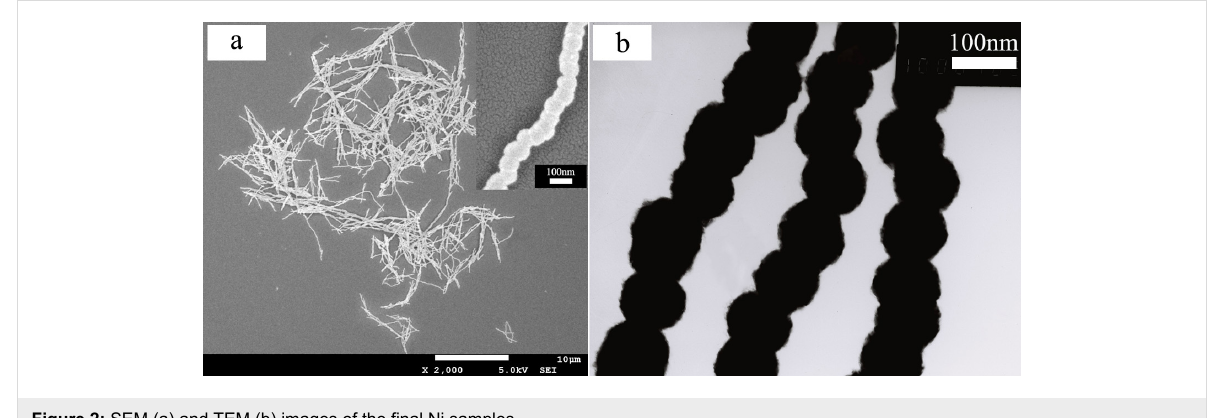
Figure 2: SEM (a) and TEM (b) images of the final Ni samples.